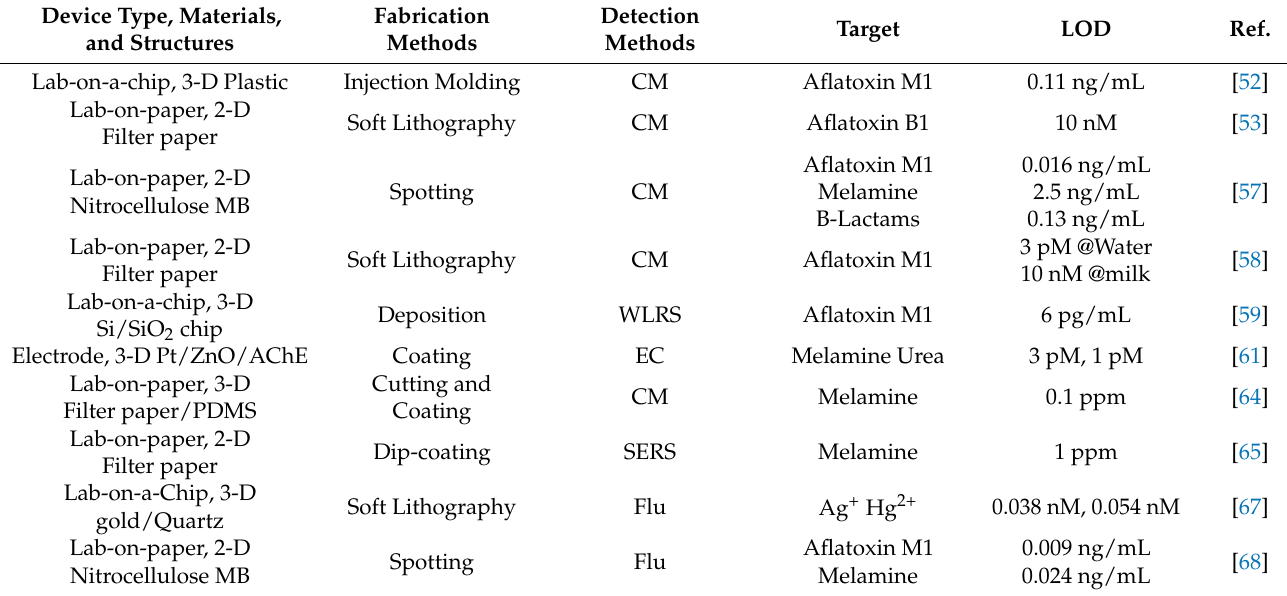
Table 1. Summary of the microfluidic devices used for milk contamination